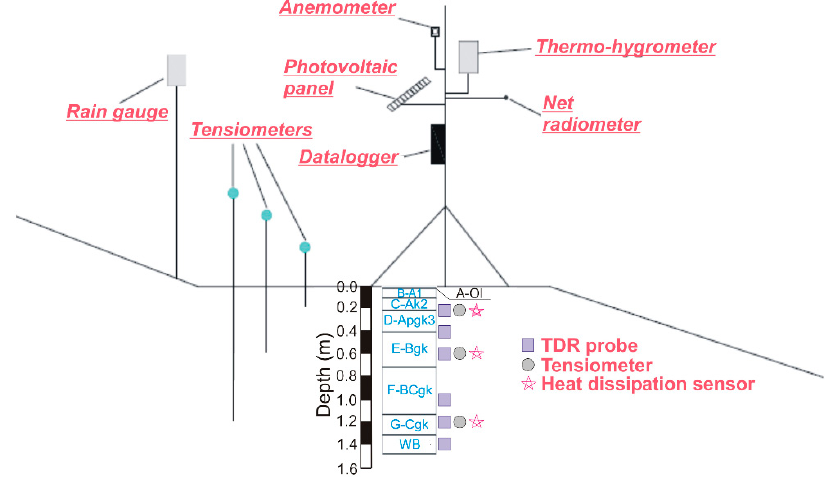
Figure 6. Schematic representation of the monitoring station and soil profile.